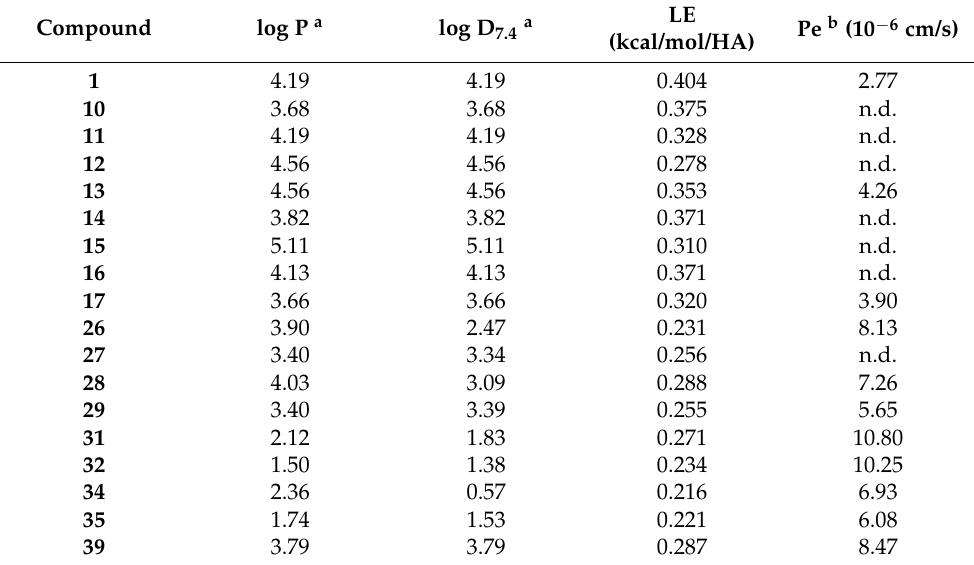
Table 2. Key physicochemical parameters and PAMPA values of compounds 1 , 10 – 17 , 26 – 29 , 31 , 32 , 34 , 35 and